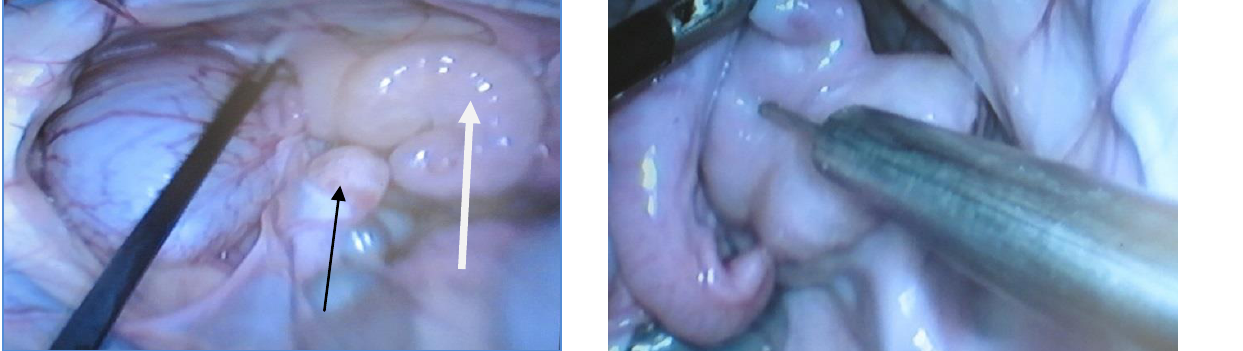
Figure, 6: Laparoscopical artificial insemination in goat uterus .